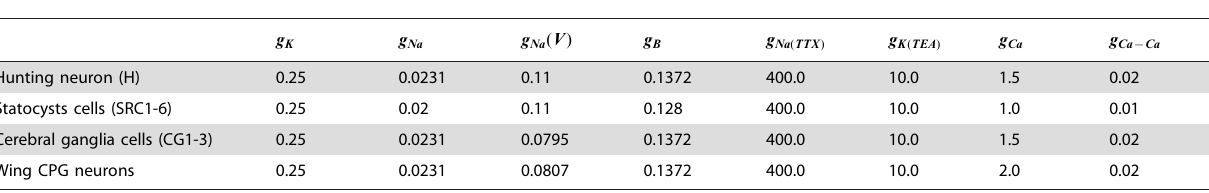
Table 2. Maximal conductances of the ionic